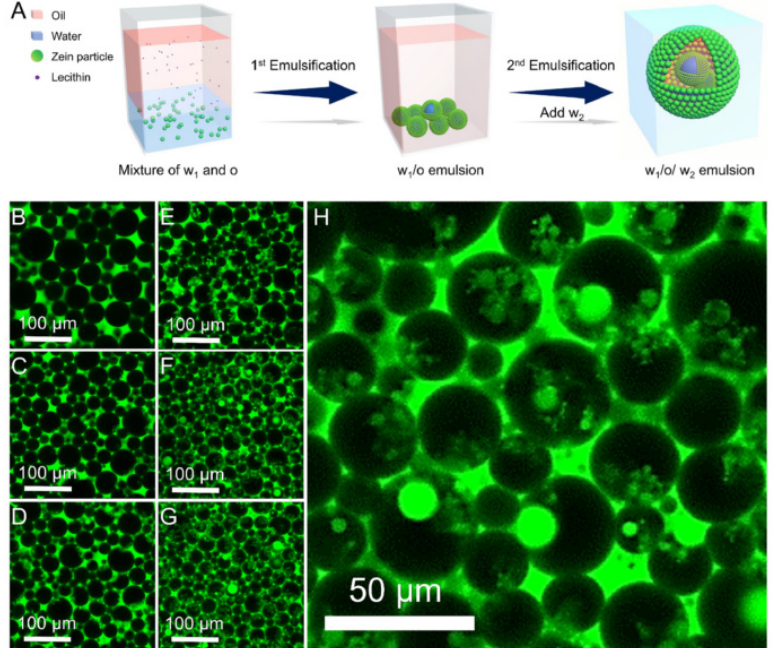
Figure 7. ( A ) Illustration of a two-step process for the preparation of lecithin based w/o/w high internal phase Pickering emulsions; ( B – G ) CLSM images of the emulsions stabilized with zein nanoparticles and lecithin, and the lecithin concentrations are 0%, 0.1%, 0.25%, 0.5%, 1%, and 2%, respectively; ( H ) CLSM image of the emulsion with 1% lecithin ( F ) at high magnification [69].